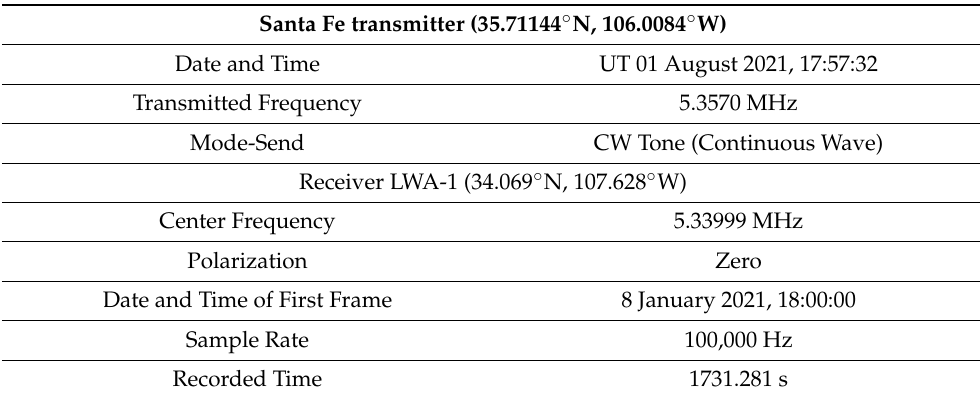
Table 2. Transmitter signal and data set specifications used during the LWA-1 experiment.